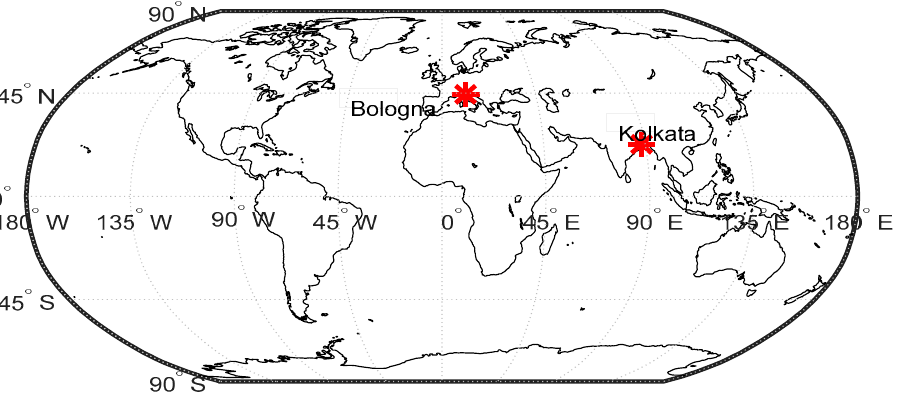
Figure 1. Location of the two study areas (red stars).